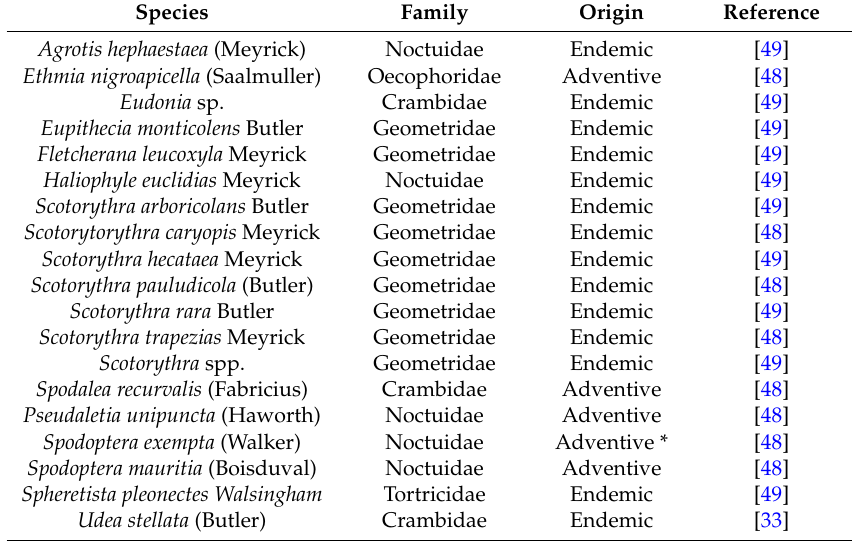
Table 1. List of known hosts of C. marginiventris in Hawaii (adventive = accidental introduction).